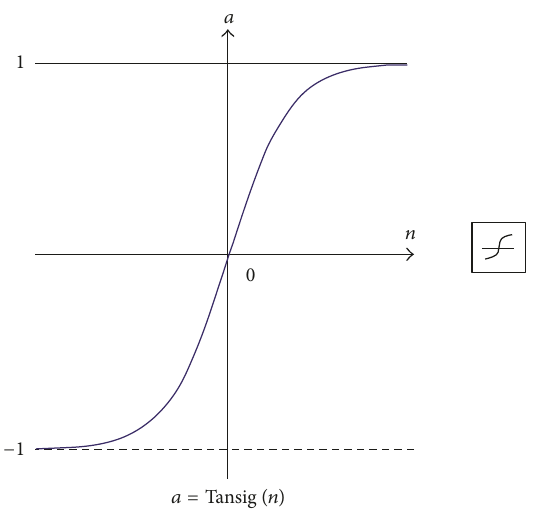
Figure 16: Nonlinear TANSIG transfer function